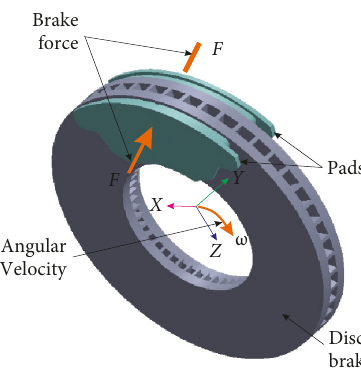
Figure 1: Disc pads assembly with forces applied to the